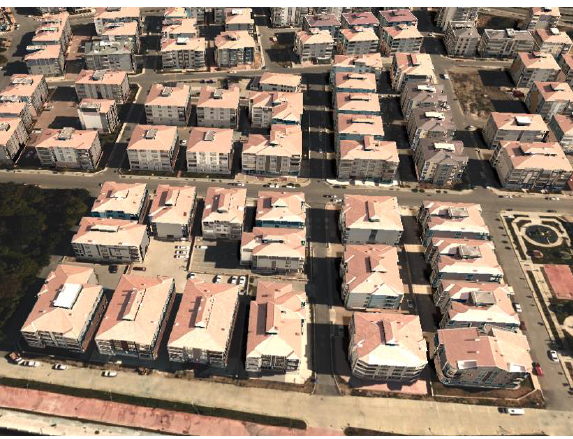
Figure 7. Example of City Model